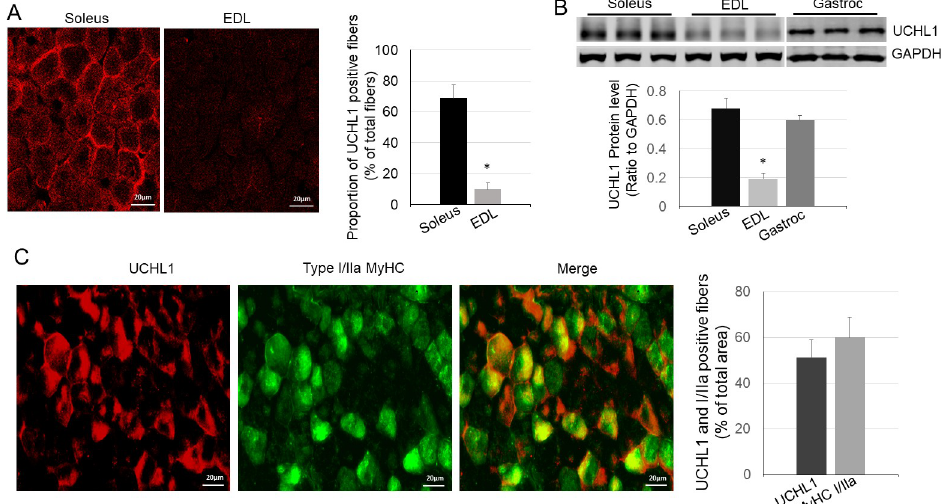
Fig 1. UCHL1 in skeletal muscle is selectively expressed in oxidative muscle fibers. A: Representative images and quantification of UCHL1 immunofluorescence of soleus (left) and EDL (right); B: Image and quantification of Western blots for UCHL1 and GAPDH from soleus, EDL, and gastrocnemius. The Western blot image was directly copied from the original membrane scan and each lane was as originally loaded without regrouping. � P < 0.05, n = 3; C: Images and quantification of immunofluorescence of gastrocnemius muscle with UCHL1 (red) and type I/IIa MyHC (green).